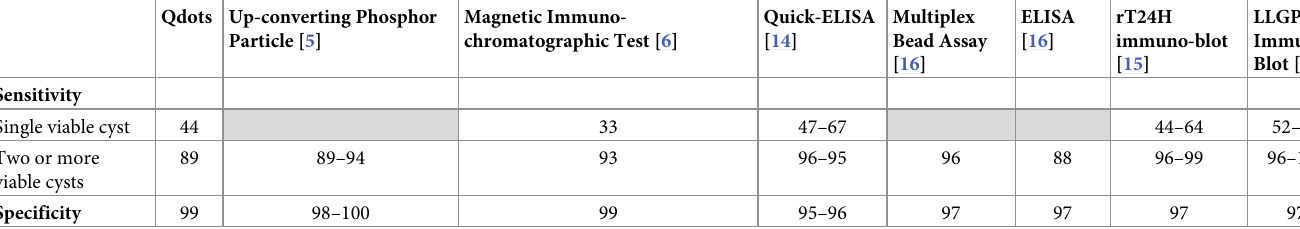
Table 2. Comparison of the performance of rT24H POC against other assay